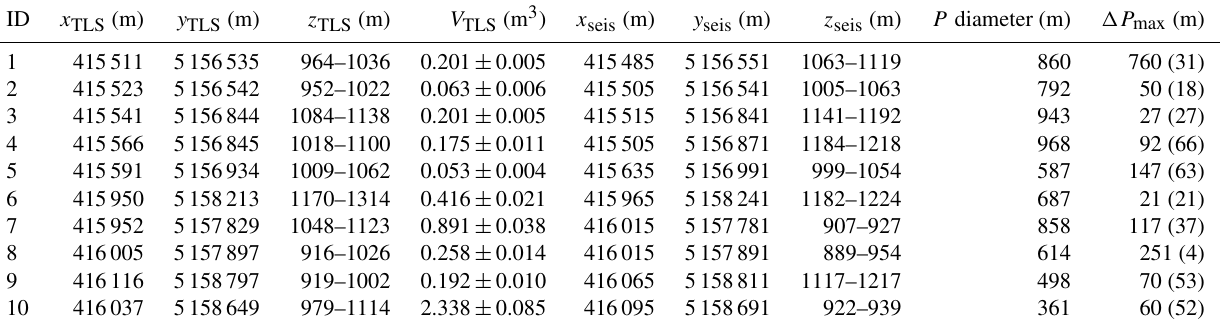
Table 1. Rockfall location summary. Subscript TLS denotes UTM coordinates from aligned TLS point cloud data. Subscript seis denotes coordinates based on seismic signal processing, i.e. site/point of the highest location probability ( P max ). Ranges of z coordinates are deter- mined as min–max range of a 3 by 3 pixel matrix around the detected location. P diameter is the greatest lateral diameter of the location uncertainty polygon (Fig. 9). (cid:49)P max is the deviation of the most likely seismic location estimate from the rockfall trajectory as determined from TLS surveys. The values outside parentheses give deviations with default settings, while values in parentheses give smallest possible deviations with optimised location frequency windows (only possible when independent location data are